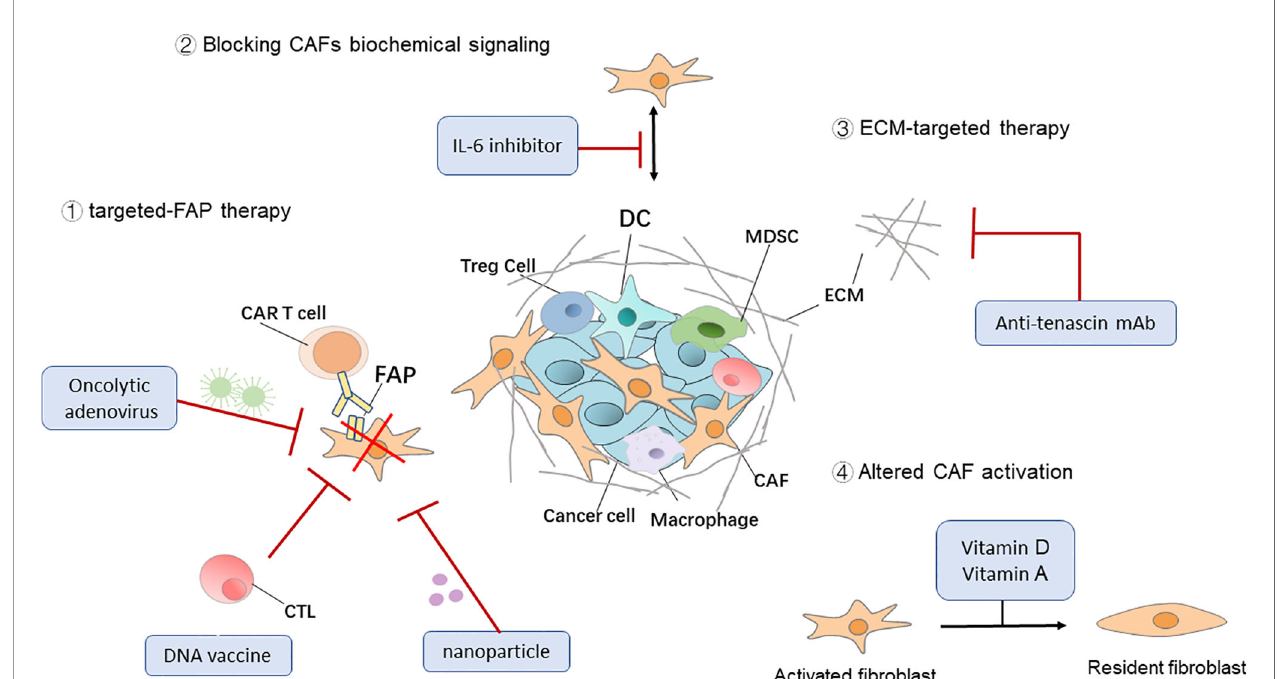
FIGURE 2 | Therapeutic targeting of CAFs. Four general approaches that target cancer-associated fi broblasts (CAFs) for cancer immunotherapy. DC, dendritic cell; Treg cell, regulatory T cell; MDSC, myeloid ‐ derived suppressor cell; ECM, extracellular matrix; CAR, chimeric antigen